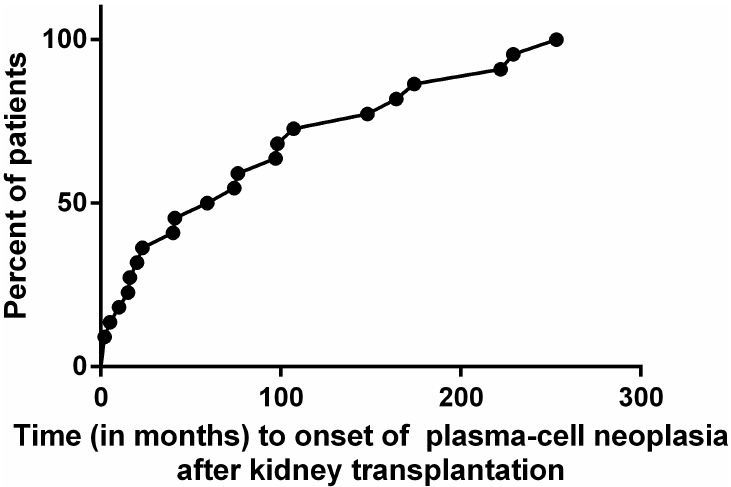
Fig 1. Time to onset of plasma cell neoplasia after kidney